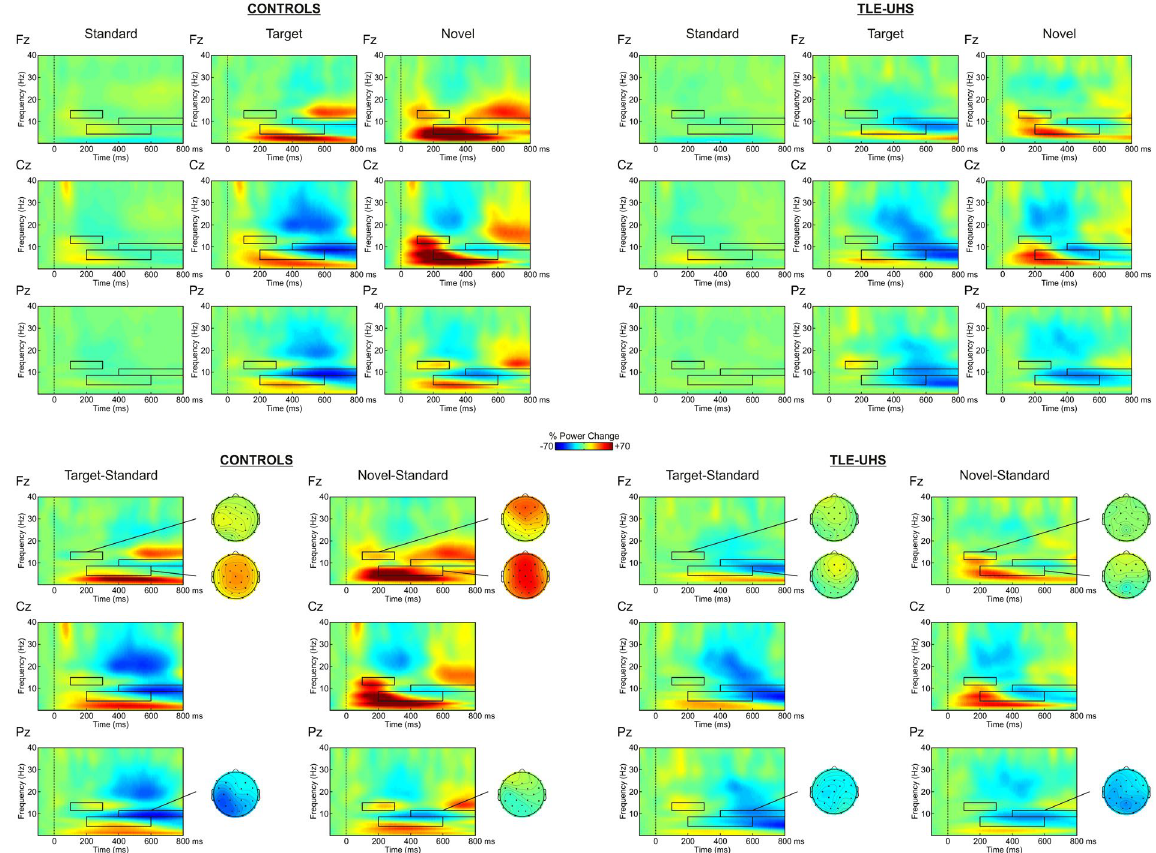
Figure 3. Grand mean CSD event-related spectral perturbation representing changes in power with respect to baseline of standard, target, and novel stimuli at midline electrodes, for the control (left) and the TLE-UHS group (right). The increase/decrease of power is represented from − 100 to 800 ms. The black squares indicate the time-windows in the different frequency bands considered for the analyses. Note that standard stimuli elicited significant low-beta ERS and alpha ERD when compared to the baseline. These differences are clearly visible with a reduced scale. Differences in power between target minus standard, and between novel minus standard are depicted at the bottom of the figure. The power distributions of the theta (4–8 hz), alpha (8–12 hz), and low-beta (12–15 hz) activities for target minus standard and for novel minus standard are